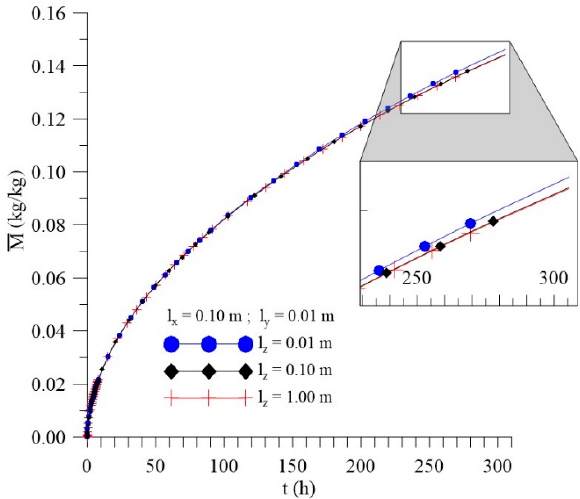
Figure 32. Kinetics of the average moisture content for different distances l z (Cases 9, 13, and 14).